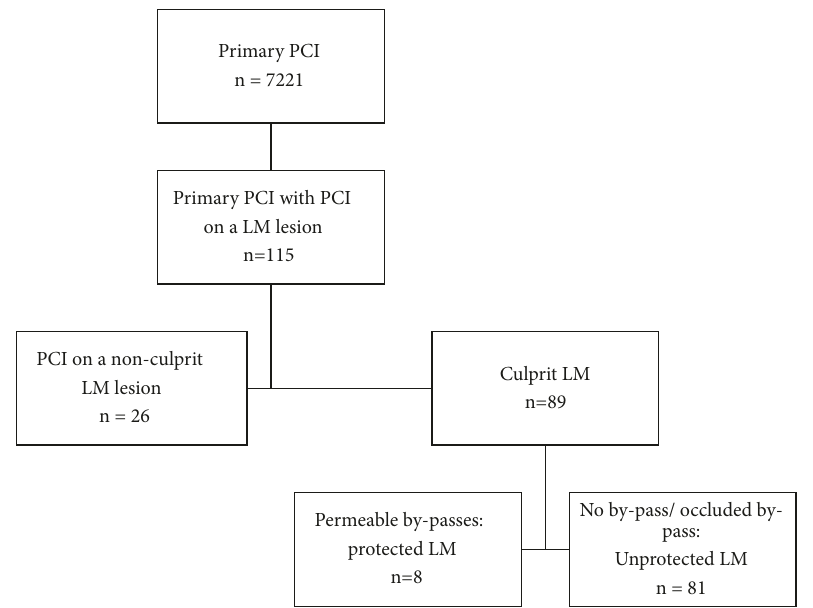
Figure 1: Flow chart. LM=left main; PCI= percutaneous coronary